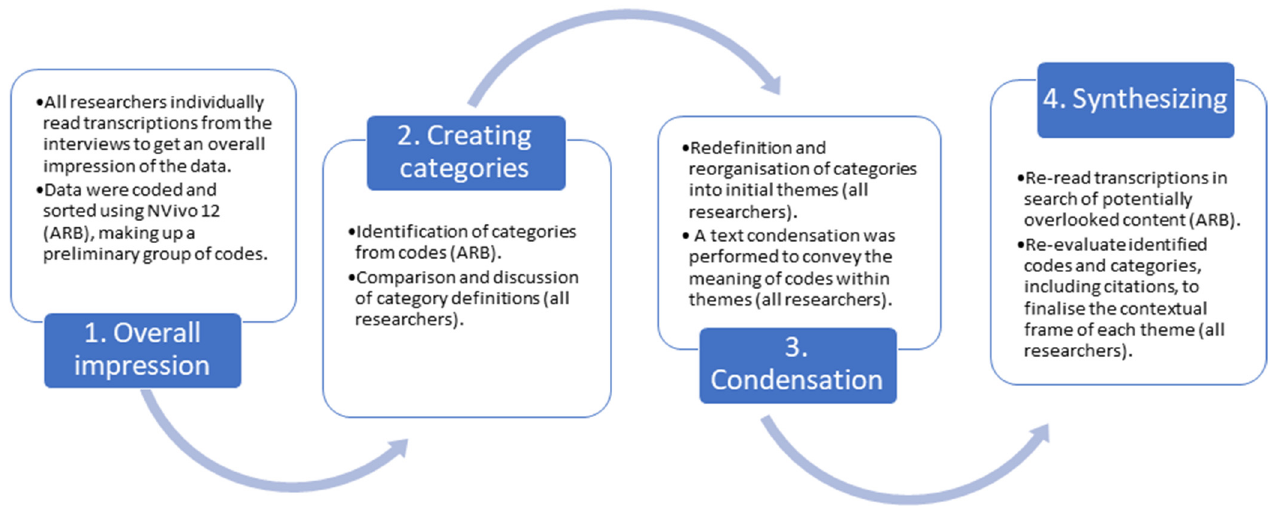
Figure 1. The analytical process uses systematic text condensation (Malterud 2012).